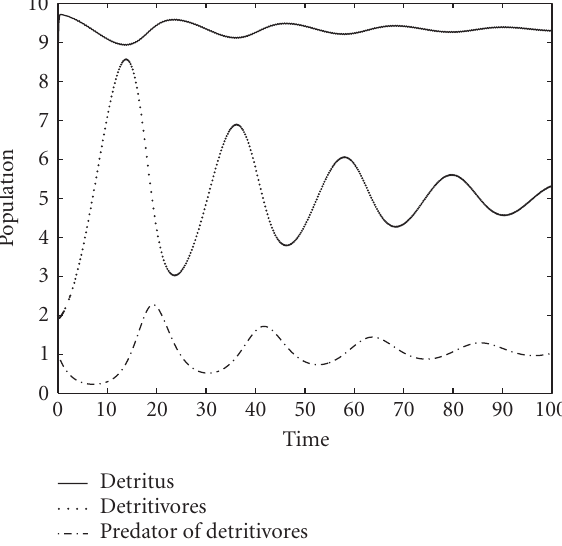
Figure 5.1. Stable population distribution of the model (5.1) with the parametric values as described in the